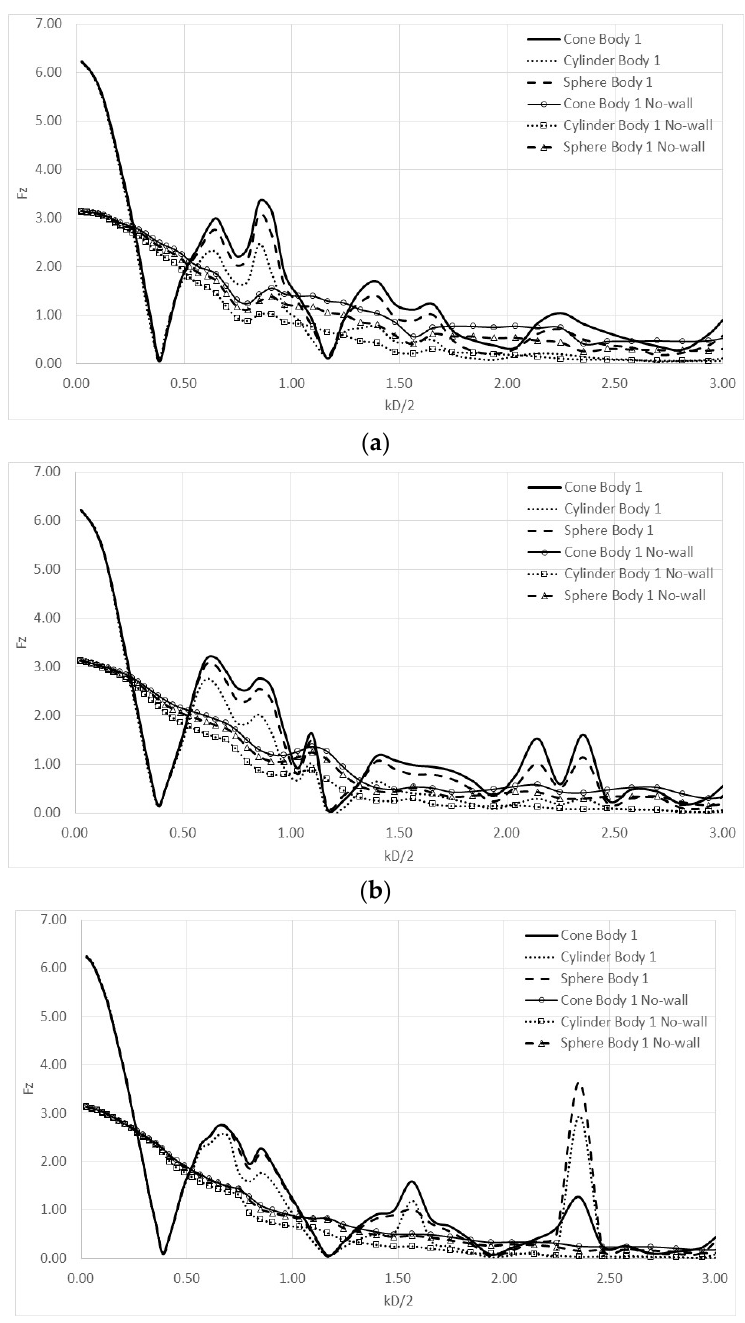
Figure 9. Dimensionless vertical exciting wave forces acting on the 1st floater of the arrays against kD / 2, for the three di ff erent examined array configurations. Comparison with the heave exciting wave forces on the same floater of the arrays without the presence of the breakwater: ( a ) parallel arrangement, C 1 ; ( b ) rectangular arrangement, C 2 ; ( c ) perpendicular arrangement, C 3 .